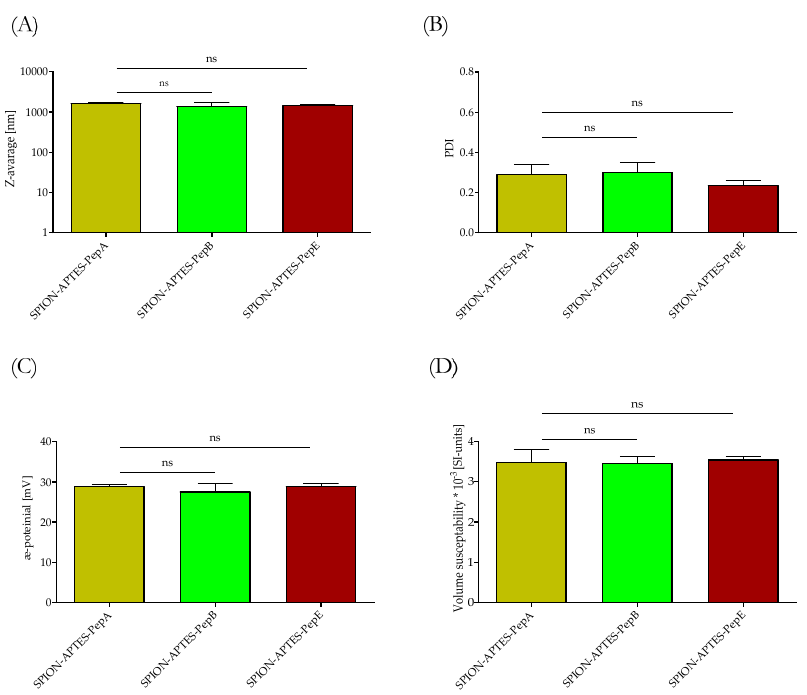
Figure 4. ( A ) Hydrodynamic size, ( B ) PDI, ( C ) ζ -potential, and ( D ) volume susceptibility of the different peptides bound to SPION-APTES. Shown are the mean values of standard deviations. Statistical testing was performed using a one-way ANOVA test. p values above 0.05 were considered non-significant (ns). 3.3. Removal of Gram-Positive Bacteria from Media under Static and Flow Conditions by Peptide-Functionalized SPION-APTES Next, the SPION-APTES particles functionalized with different peptides were tested for the magnetic removal of intact bacteria from the suspensions. Ringer solution was cho- sen as the aqueous medium because it contains Ca 2+ , which is necessary for the binding of the peptide to the bacteria [25,29]. Under static conditions, SPION-APTES PepE/antibPep failed to bind and remove the tested bacteria from the medium (Figure 5), confirming the results from the agglutination experiments (see Figure 1). A slight difference between the three peptides (A, B, and E) and the two bacterial species tested was found, as before. Higher amounts of S. pneumoniae remained in the supernatant compared to S. aureus . SPION-APTES-PepA could almost completely remove S. aureus from the medium, while a minor amount of S. pneumoniae remained in the supernatant after separation. Efficiency of SPION- APTES-PepA was over 99 % and about 96 % for removal of S. aureus and S. pneumoniae , respectively. For SPION- APTES-PepB, these values were about 98 % and still about 91 %, respectively..